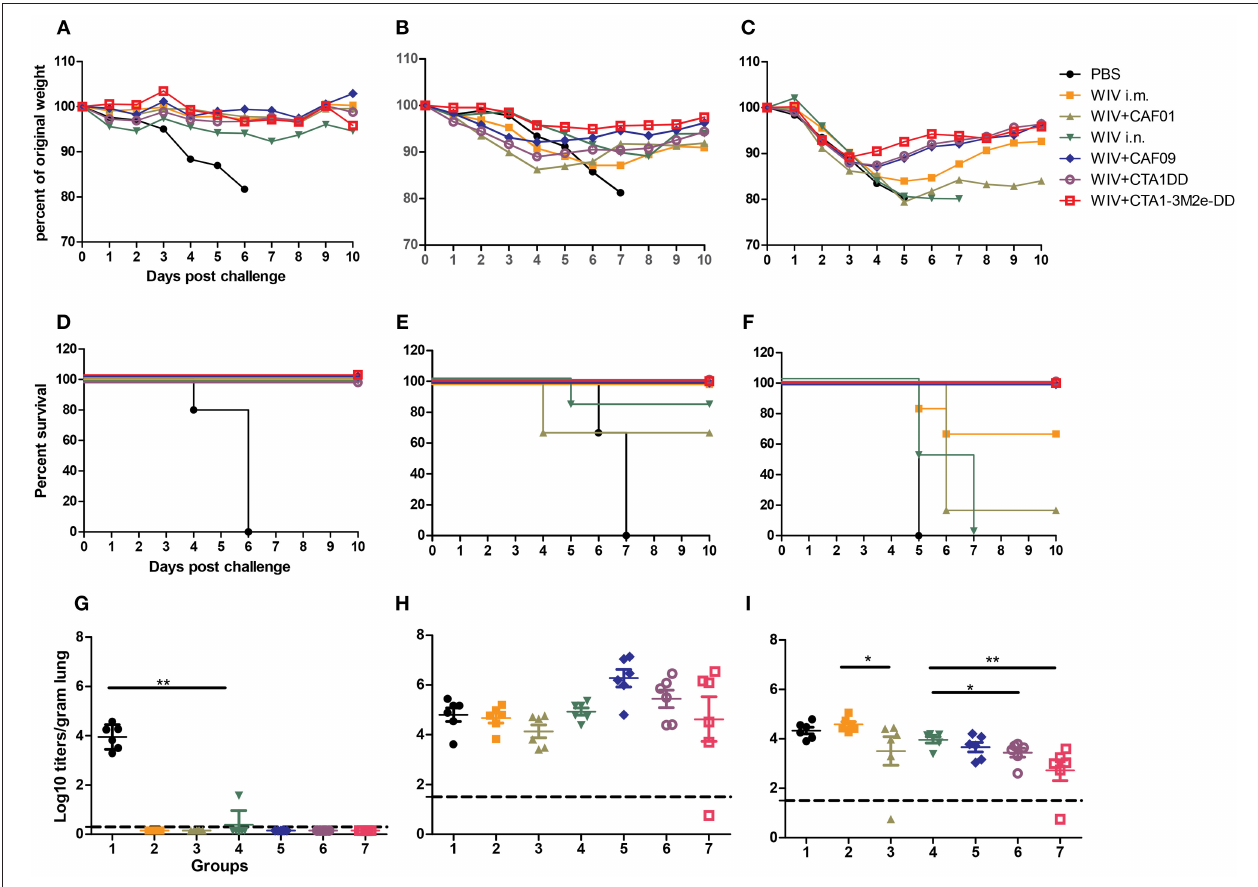
FIGURE 1 | Adjuvanted i.n. administered vaccine provides best protection. CB6F1 mice were vaccinated thrice 10 days apart with PBS, non-adjuvanted or adjuvanted WIV vaccines. Three weeks after the last vaccination, 6 mice/group were challenged with homologous PR8 (H1N1) (A,D,G) , heterologous A/California/7/2009 (H1N1)pdm09 (B,E,H) or heterosubtypic X-31 (H3N2) viruses (C,F,I) . Six animals/group were followed for 10 days for weight loss (A–C) and survival (D–F) . Three days post challenge 6 mice/group were sacrificed for determining lung viral load (G–I) . Groups are represented as in Table 1 : 1: PBS, 2: WIV i.m., 3: WIV + CAF01 i.m., 4: WIV i.n., 5: WIV + CAF09 i.n., 6: WIV + CTA1-DD i.n., 7: WIV + CTA1-3Me-DD i.n. Dashed line indicates Limit of detection (LoD) ( G–I ). Virus titers are represented as log 10 titers/gram of lung tissue with level of significance as * p < 0.05 and ** p < 0.01 calculated using Mann-Whitney U